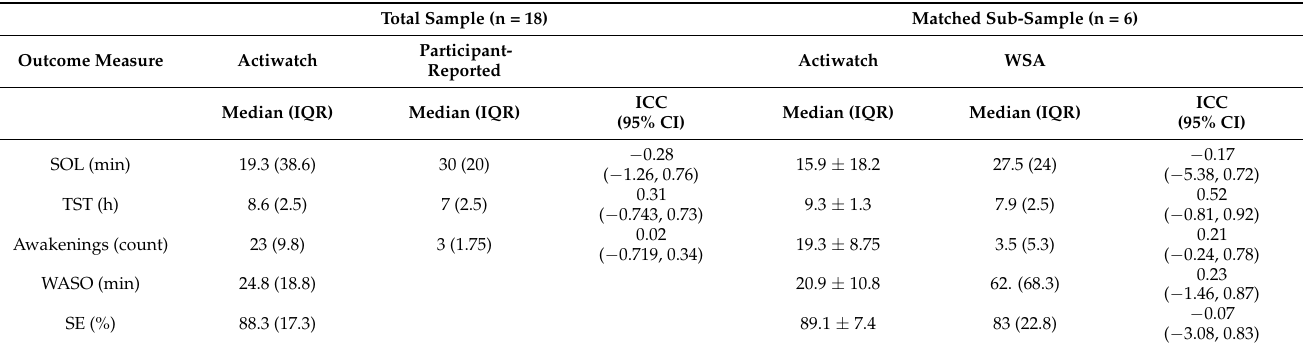
Table 2. Measurement of sleep